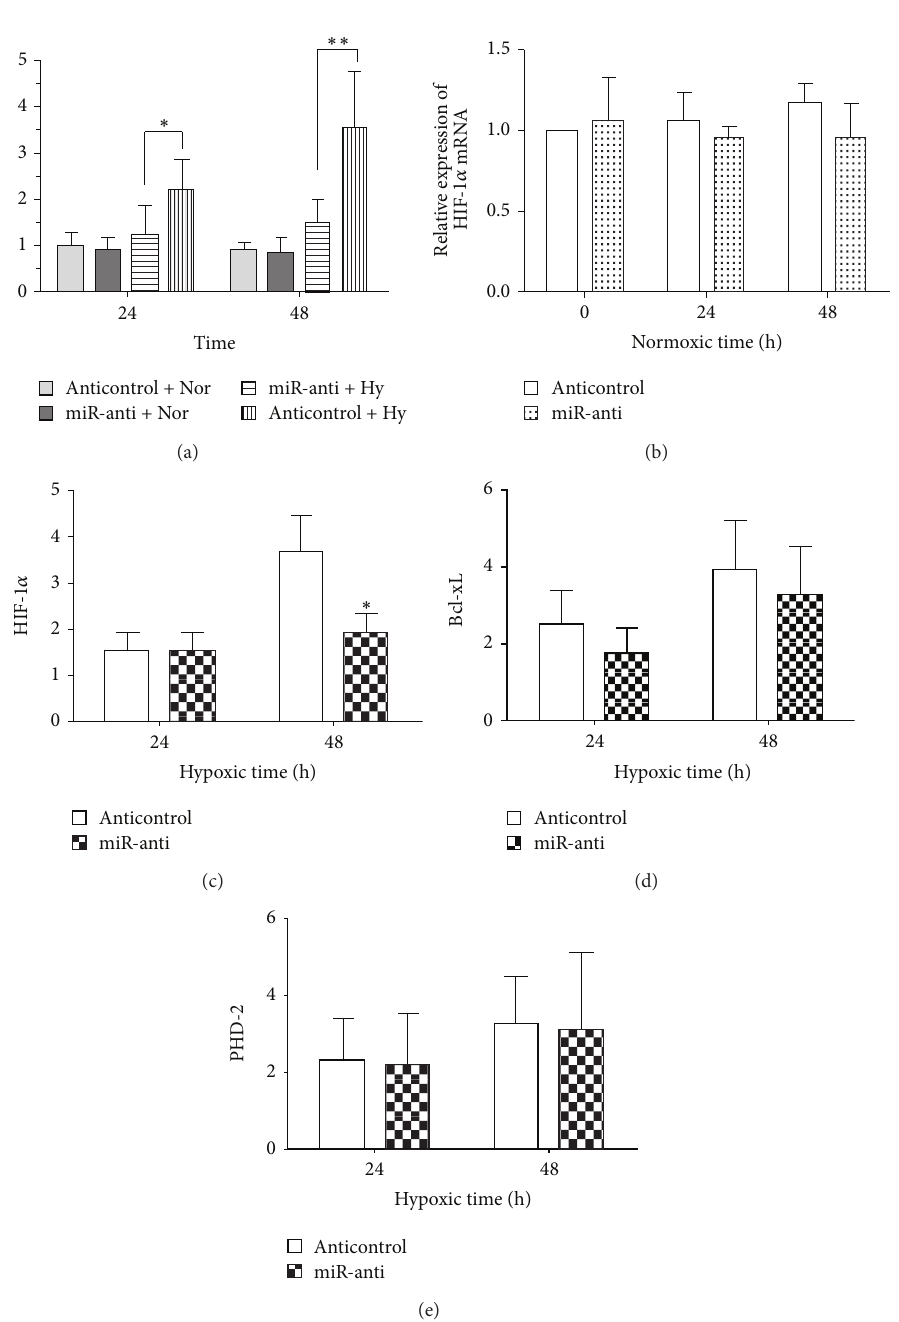
Figure 2: Downregulated miR-210 affected the expression of HIF-1 𝛼 and HIF-1 𝛼 -regulated molecules (BCL-xl and PHD-2) in C28/I2 cells on hypoxia and normoxia. Cells was harvested at 24h and 48h on hypoxia or on normoxia after being transfected with miR-anti or anticontrol. Then, the qRT-PCR assay was conducted to examine the expression of HIF-1 𝛼 (b) on normoxia. The same method was utilized to analyze the differences in expression of HIF-1 𝛼 (c), BCL-xl (d), and PHD-2 (e) mRNA between in cells transfected with miR-anti and that with anticontrol on hypoxia. The expression of miR-210 was also confirmed in these groups (a). The qRT-PCR was performed in three individual experiments. Significant differences were denoted as ∗ 𝑃 < 0.05 and ∗∗ 𝑃 < 0.01